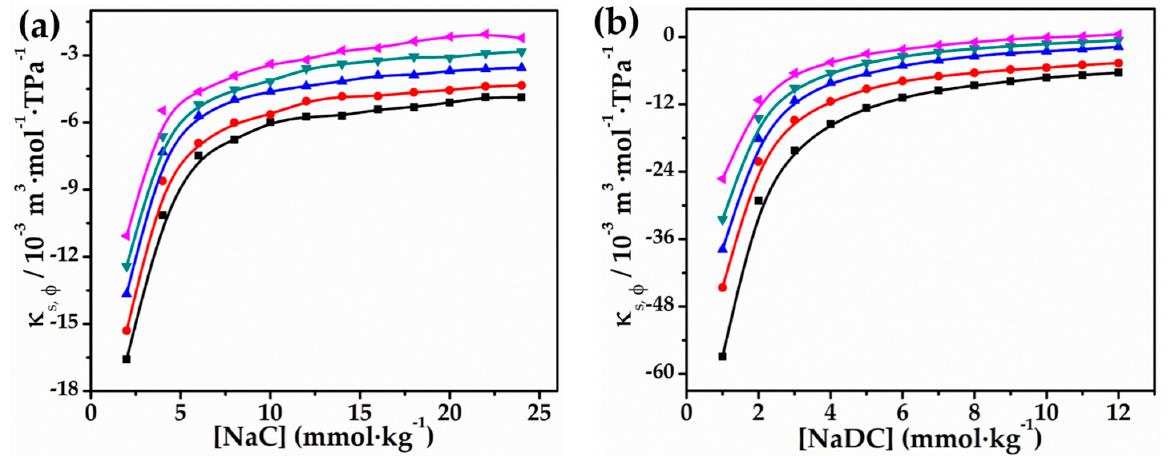
κ Figure 3. Plots of κ s , ϕ vs. ( a ) [NaC] and ( b ) [NaDC] in 0.010 mol · kg − 1 aqueous solution of glycyl Figure 3. Plots of φ , s vs. ( a ) [NaC] and ( b ) [NaDC] in 0.010 mol ∙ kg –1 aqueous solution of glycyl glycine at 293.15 K ( (cid:4) ), 298.15 K ( • ), 303.15 K ( (cid:78) ), 308.15 K ( (cid:72) ), and 313.15 K ( (cid:74) glycine at 293.15 K ( ■ ), 298.15 K ( ● ), 303.15 K ( ▲ ), 308.15 K ( ▼ ), and 313.15 K ( ◄ ). Table 2. Apparent molar volume, ϕ V /10 − 4 (m 3 ∙ mol − 1 ) values for NaC and NaDC in pure water and